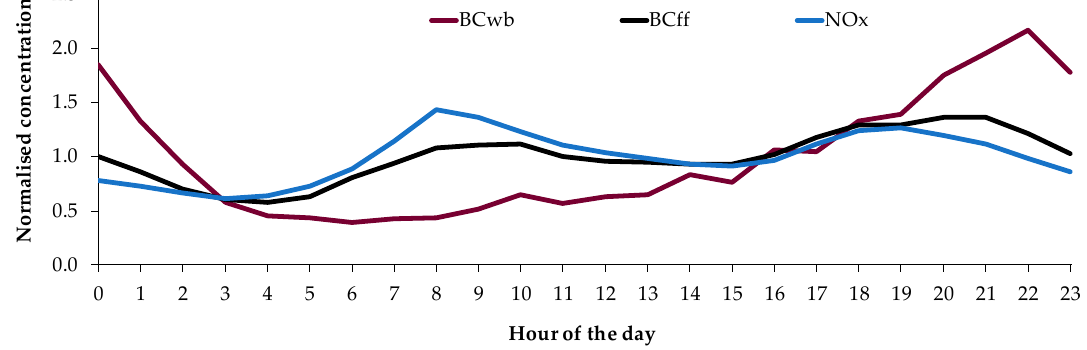
Figure 5. Mean diurnal variability of BC wb , BC ff and NO x normalised concentrations (based on corresponding mean values) during the cold period.